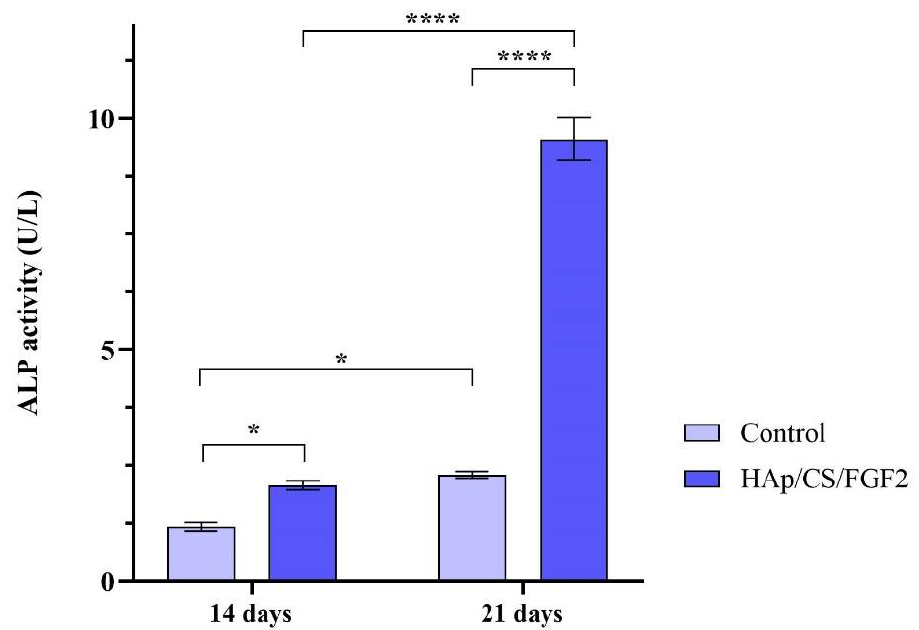
Figure 8. ALP activity assessment in culture media harvested from MC3T3-E1 cells seeded on control samples and HAp/CS/FGF2 coatings during 21 days of exposure to osteogenic inductors (* p < 0.5; **** p < 0.0001).